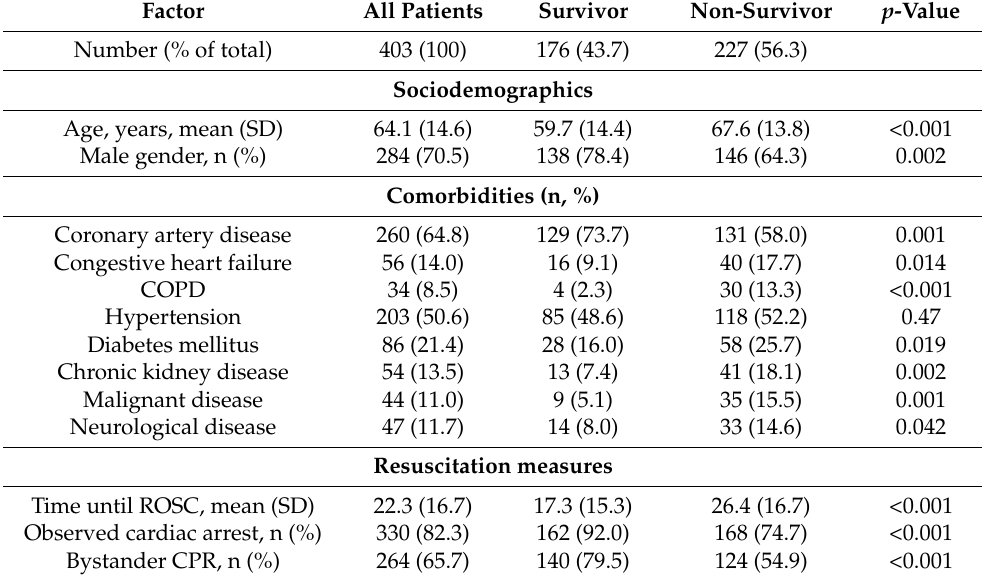
Table 1. Baseline